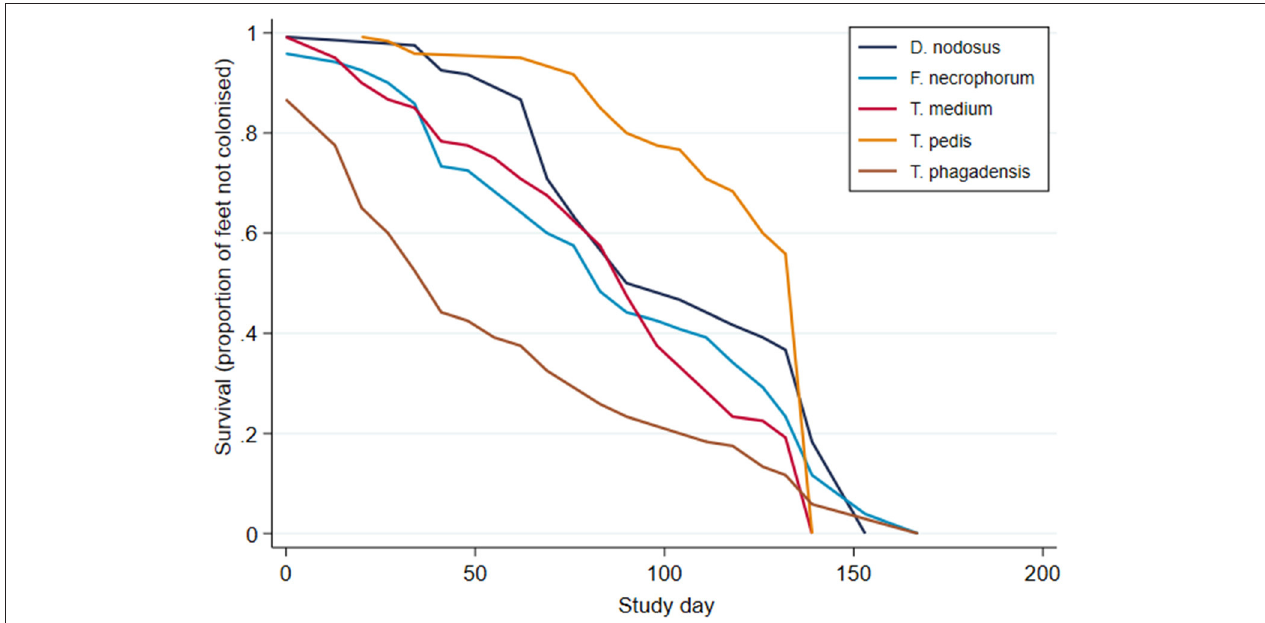
FIGURE 8 | Kaplan–Meier survival curves for time to first bacterial colonization of a foot ( n = 30 sheep, n = 120 feet).